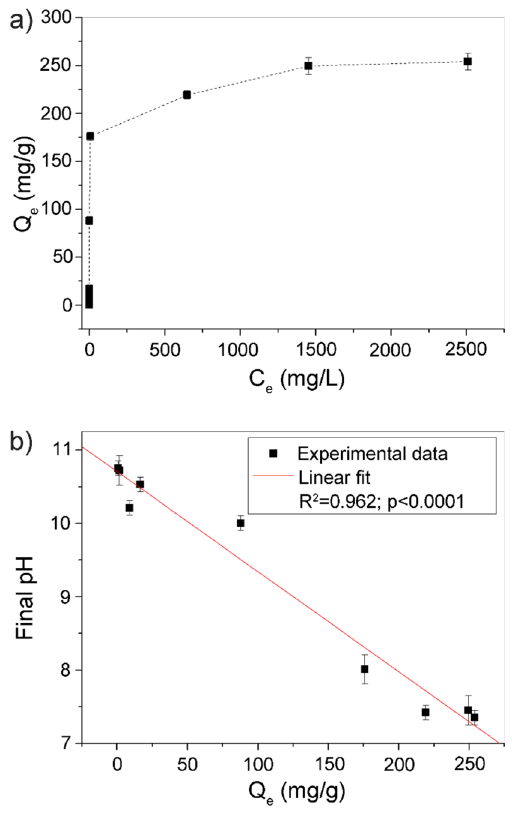
Figure 4. The isotherm of Sr sorption by Z4A ( a ) and the relationship between final pH values and the amounts of Sr sorbed ( b